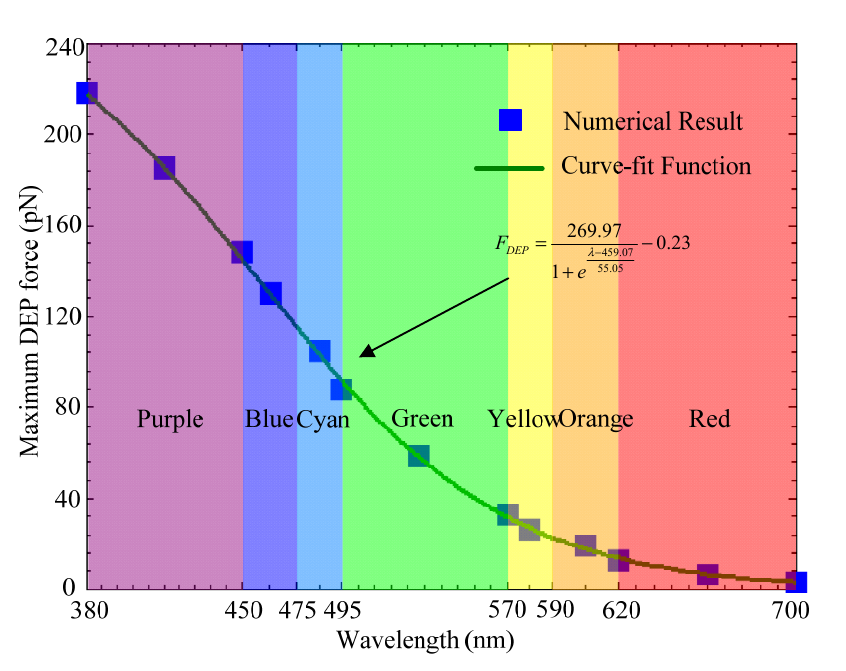
Figure 4. Maximum DEP force acting on a 10 μ m polystyrene bead with respect to different light colors (optical wavelength). The simulation conditions are exactly the same as those given in Figure 3. The results indicate that the maximum DEP force decreases with increasing optical wavelength following the Fermi-Dirac Function